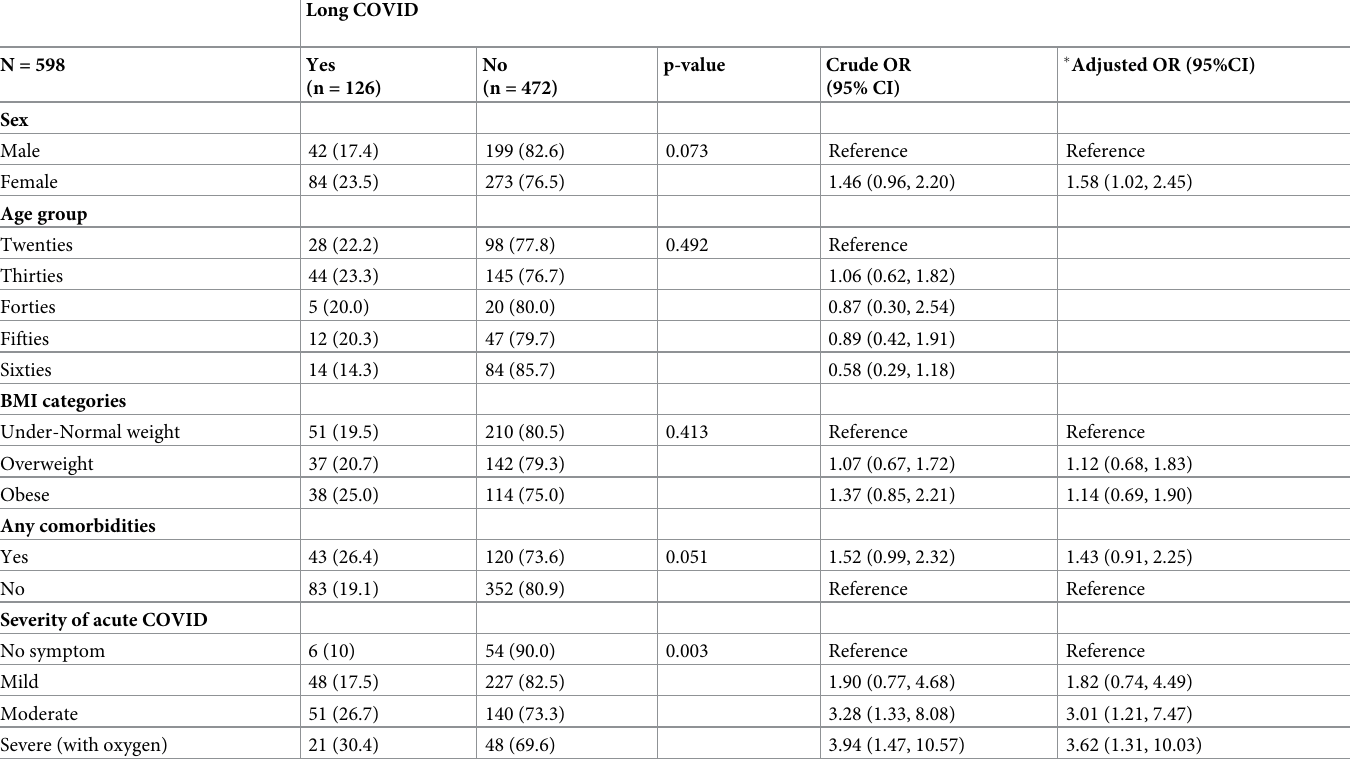
Table 4. Factors associated with Long